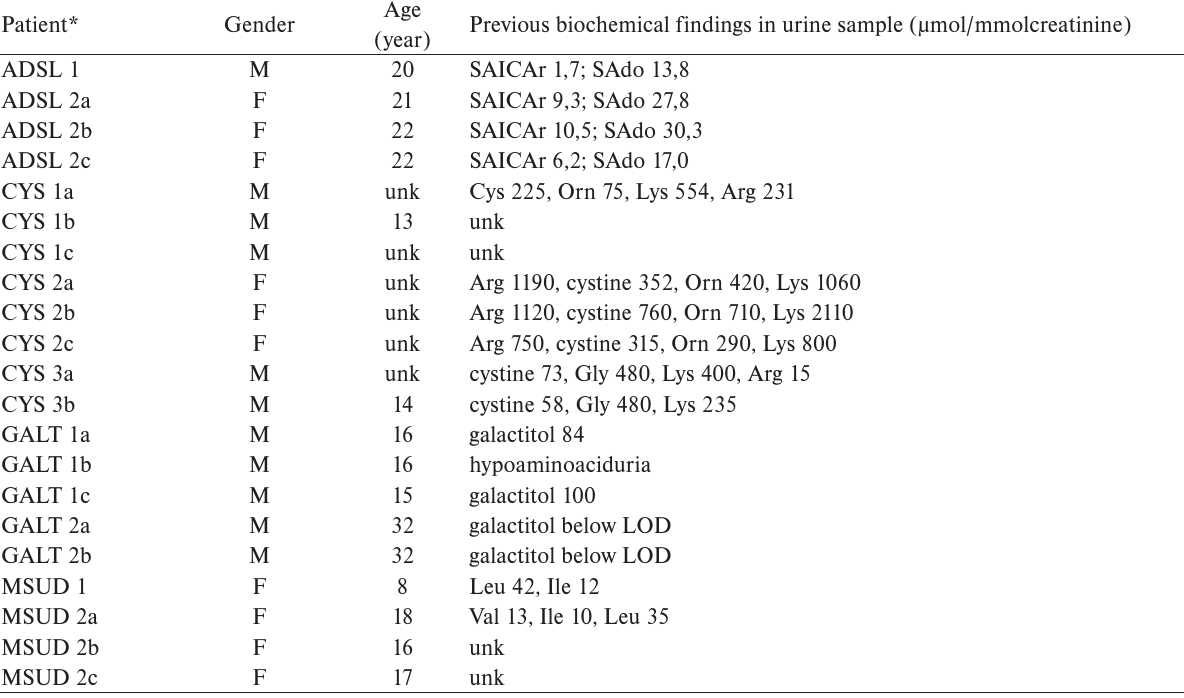
Table 2. Summary of analyzed urine samples from patients with